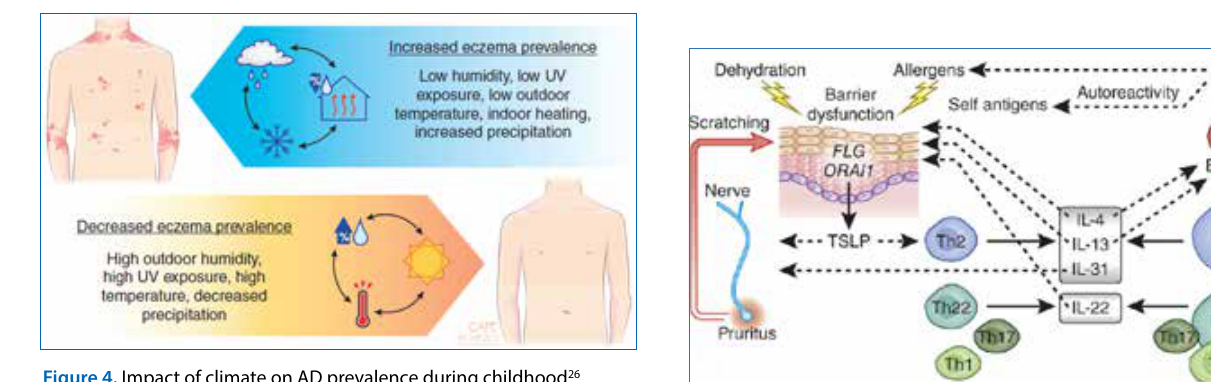
Figure 4. Impact of climate on AD prevalence during childhood 26